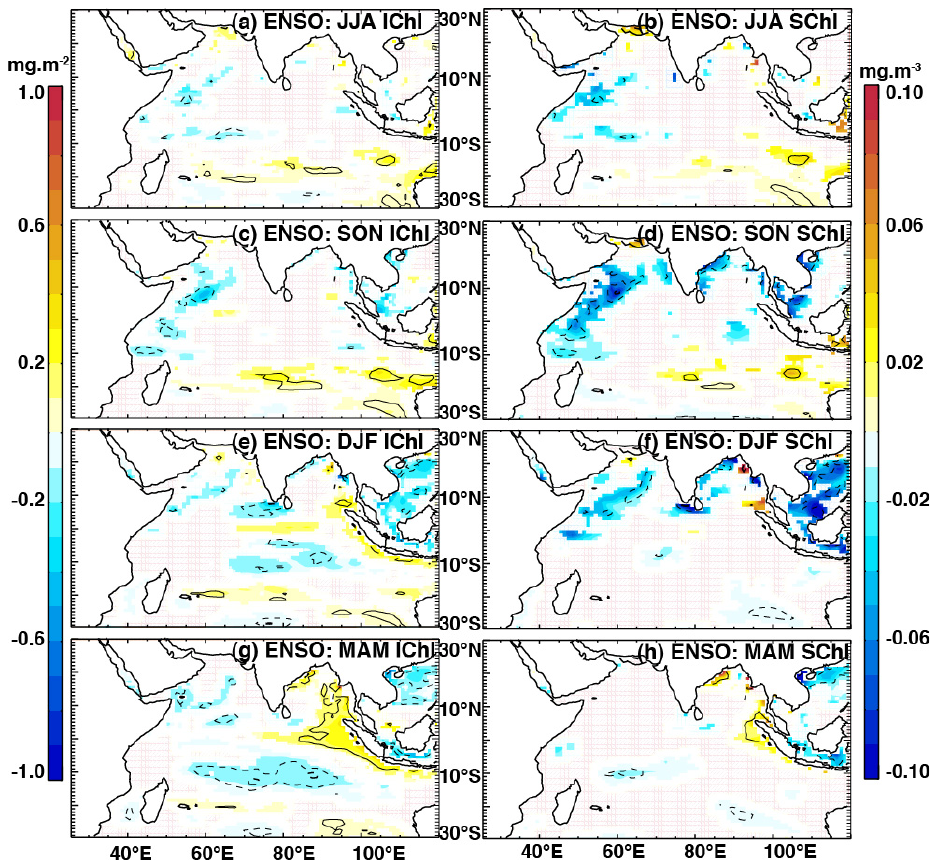
Fig. 8. The impacts of ENSO on I Chl (left panels) and S Chl (right panels), as indicated by partial regression coefficients of their anomalies regressed onto the ENSO index, having removed the influence of IOD (Eqs. 4–6). Regressions were computed for the period 1961–2001 and their coefficients were drawn only when beyond a 90% significance level. Thin and thick contours indicate correlation coefficients of 0.4 and 0.6 respectively, while solid (dashed) lines represent positive (negative)